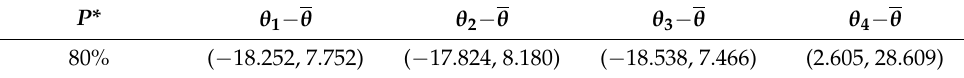
Table 2. The 80% two-sided confidence interval for four types of lung cancer compared with